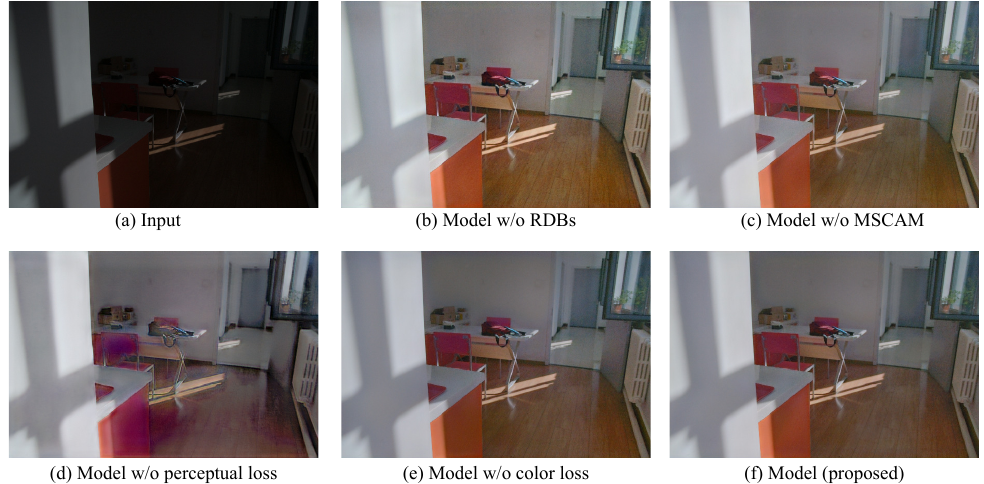
Figure 12. Visual comparison of ablation studies on LOL testing